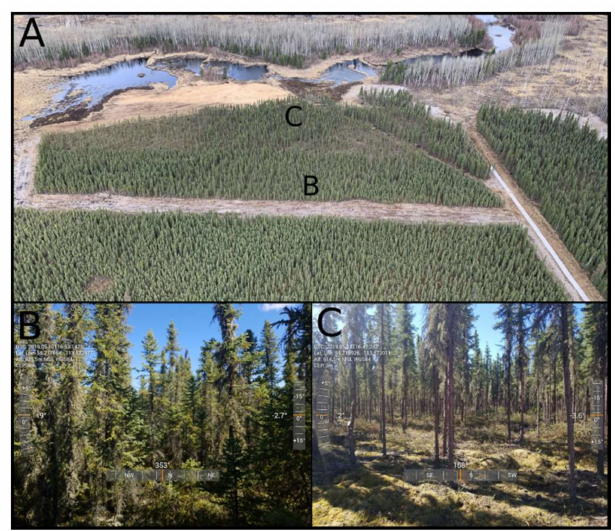
Figure 2. ( A ) Aerial photo of experimental block Unit 5, ( B ) control area, and ( C ) treated area. A pre- existing NW-trending cutline was present in the eastern-most portion of the treated area, creating a triangular block that was also